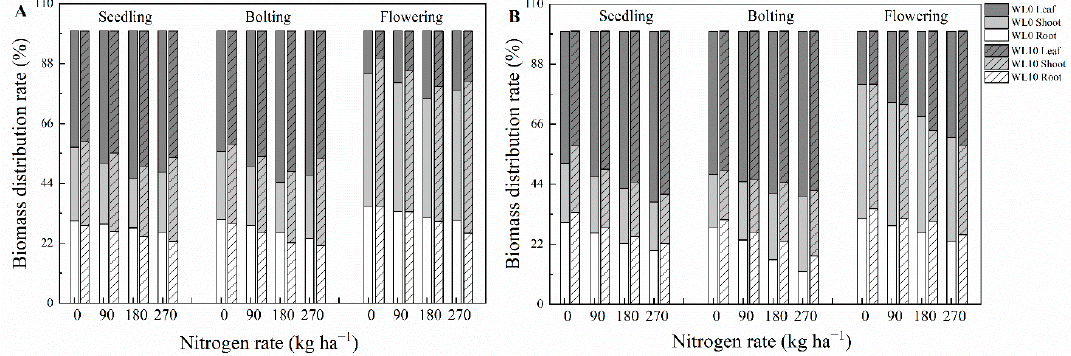
Figure 2. Effects of nitrogen rates on dry matter partition per plant of waterlogged rapeseed ( A , ZS 9; B , GH 01). WL0, plants without waterlogging; WL10, plants waterlogged for 10 days at the seedling